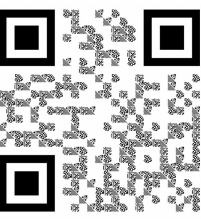
Figure 4. An example of a 2LQR code for copy detection.